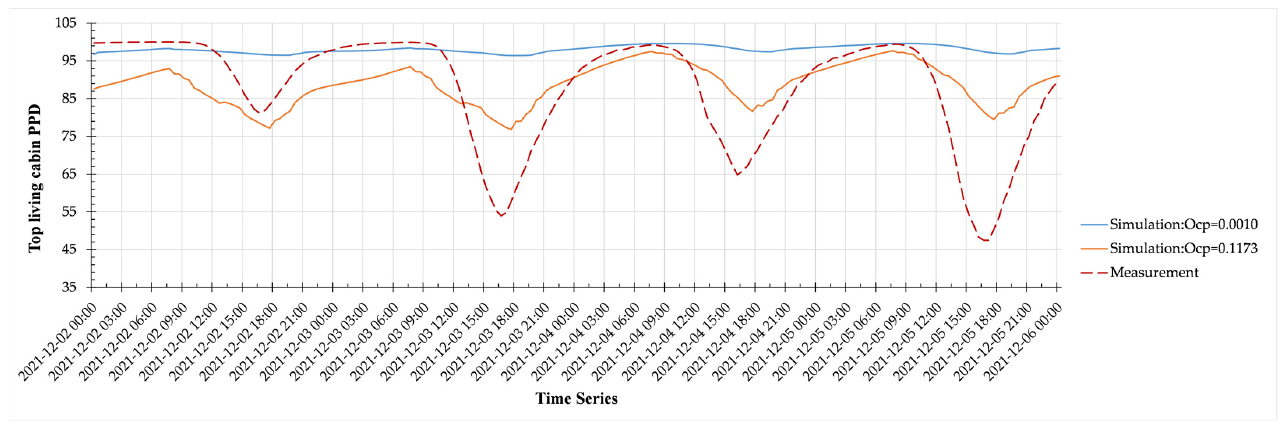
Figure 20. Top living cabin: predicted mean vote between 2 and 5 December 2021.